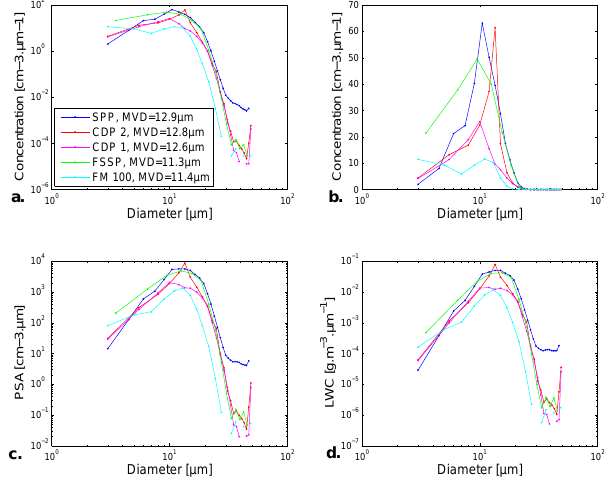
Figure 3. Averaged size distribution in concentration, with (a) loga- rithmic and (b) linear scale, (c) surface and (d) LWC for the 16 May over the period of time shown in Fig. 1 (i.e., 12:46 to 14:17). The colors correspond to the different instruments displayed in the leg- end. The data have been selected for wind coaxial measurements. The average median volume diameter MVD is also